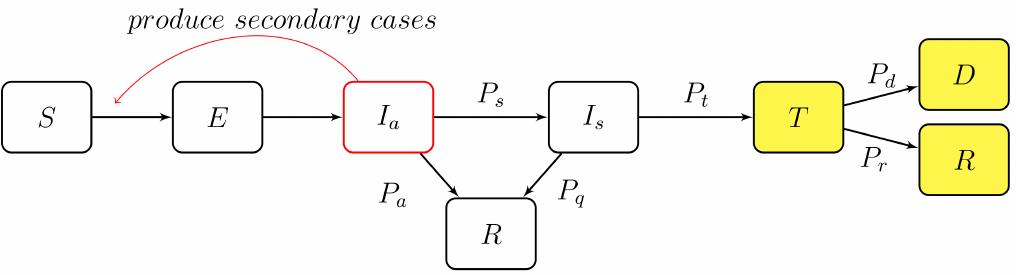
Figure 2. The compartments and the probabilities of each path. Data provided by health authorities are available for the compartments colored in